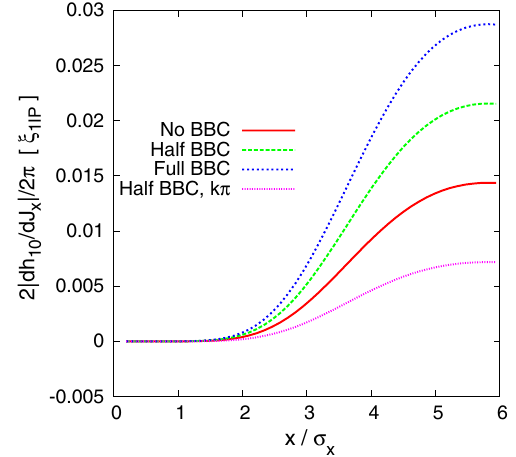
FIG. 3. 10th order horizontal beam-beam resonance widths under different beam-beam conditions. The vertical axis is in